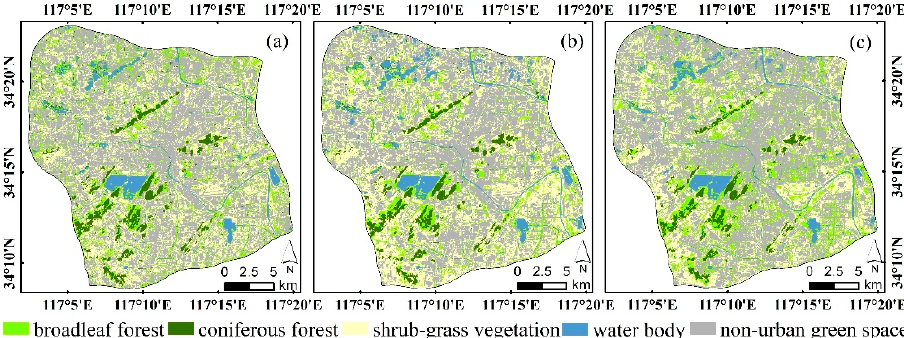
Figure 4. UGS distribution in Xuzhou: ( a ) 28 August 2016; ( b ) 14 June 2018; ( c ) 23 June 2021.